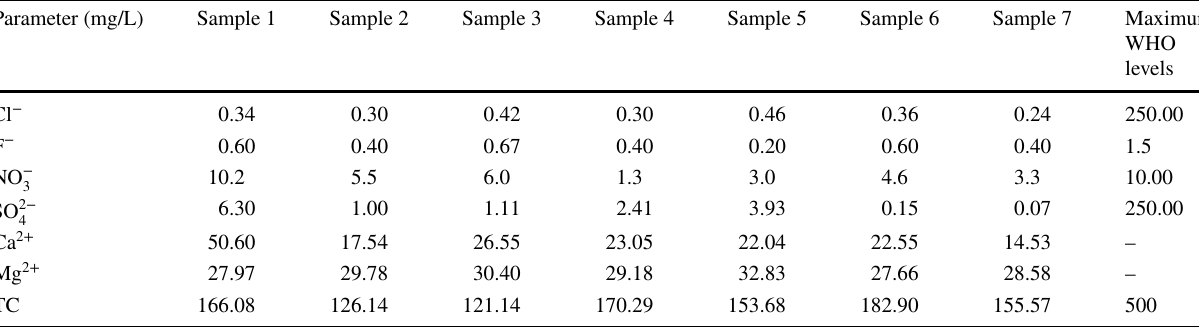
Table 2 The major constituents of Kakamega bore-hole